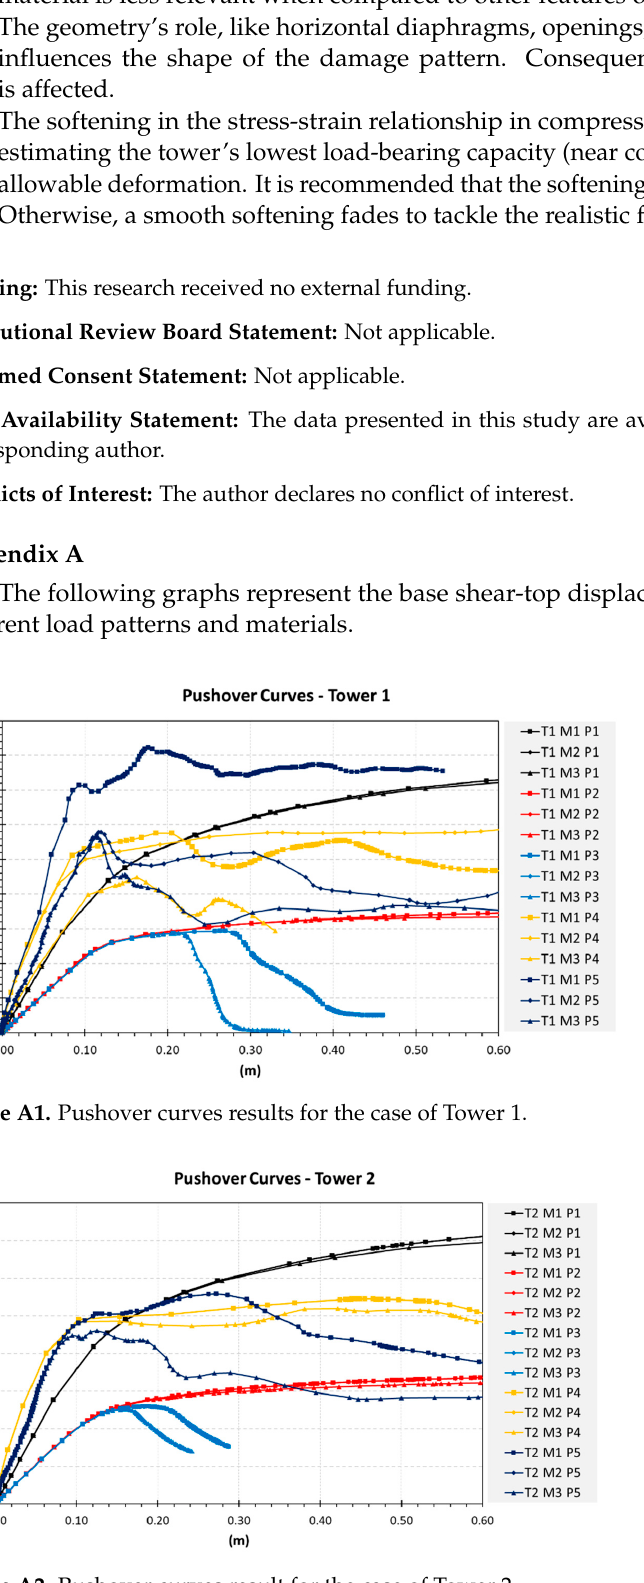
Figure A2. Pushover curves result for the case of Tower 2.